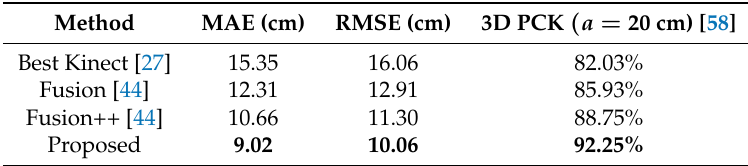
Table 6. Comparative evaluation of the motion capture results of the respective methods, presenting total MAE, RMSE and 3D PCK ( α 3 D = 20 cm)